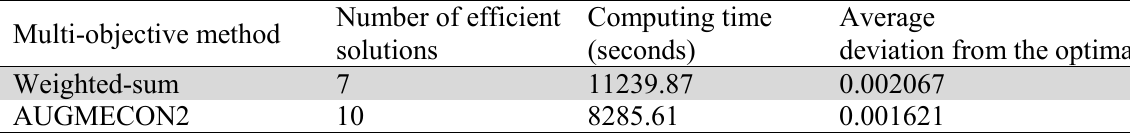
Results for the second scenario and ten grid points. Multi-objective method